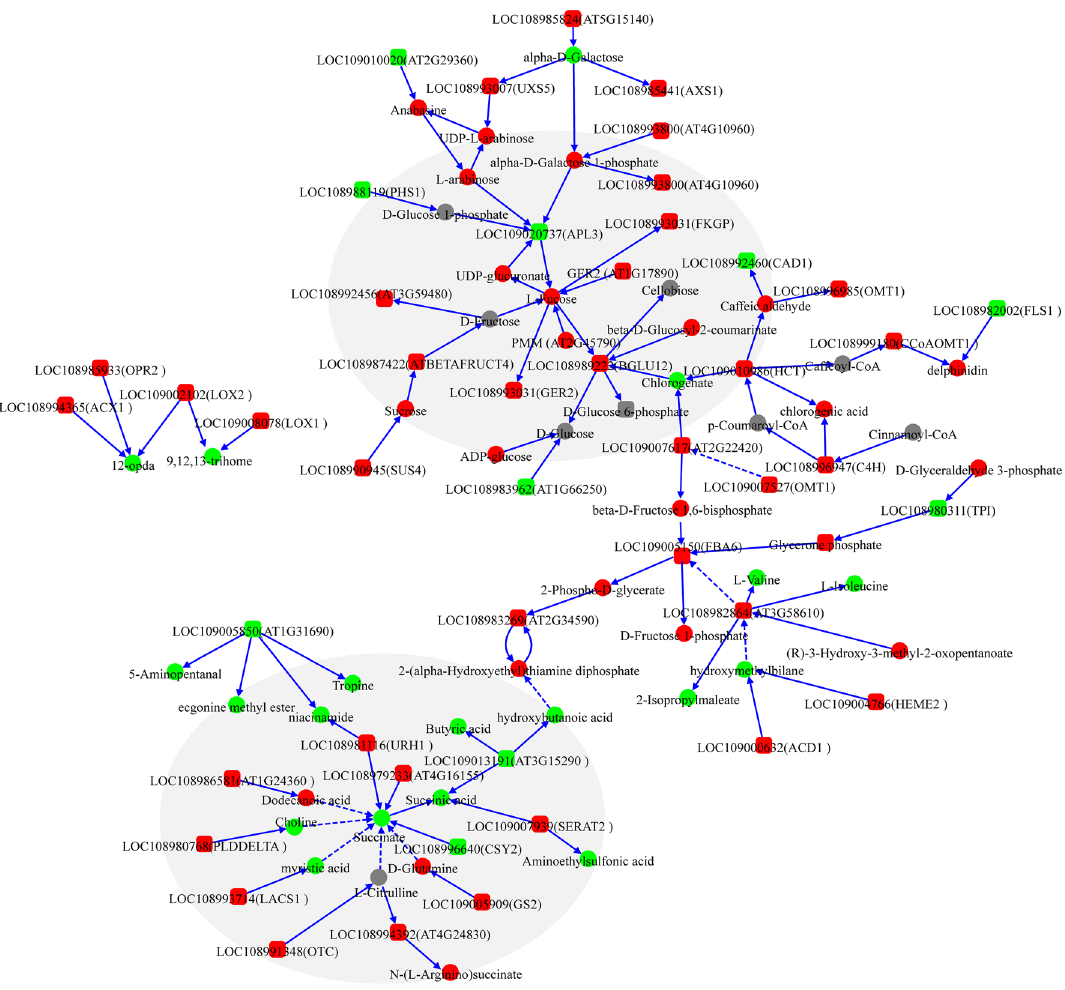
Figure 6. The core biological response pathway of pecan to salt stress. Based on the KEGG pathway, the DEM and DEP correlation analysis results are mapped to a comprehensive metabolic regulation network diagram. The DEMs and proteins are marked as circles and round rectangles, respectively; red indicates upregulation; green indicates downregulation. The key DEPs and DEMs are shown in the light gray background